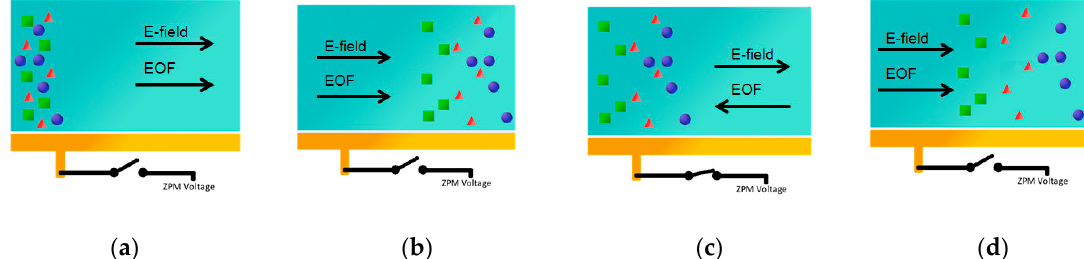
Figure 2. Illustration of switching EOF separation enhancement method. The blue ( ● ) ions have the highest mobility, followed by the red ( ▲ ) ions, with the green ( ■ ) ions having the lowest mobility. ( a ) Sample of mixed ions injected into channel. ( b ) Sample approaches end of channel. Sample starts to separate but many ions still overlap. ( c ) Voltage applied to ZPM electrode. EOF reversed sending ions back to start of channel whilst maintaining their separation. ( d ) Sample approaches end of channel again. Separation of sample is improved.